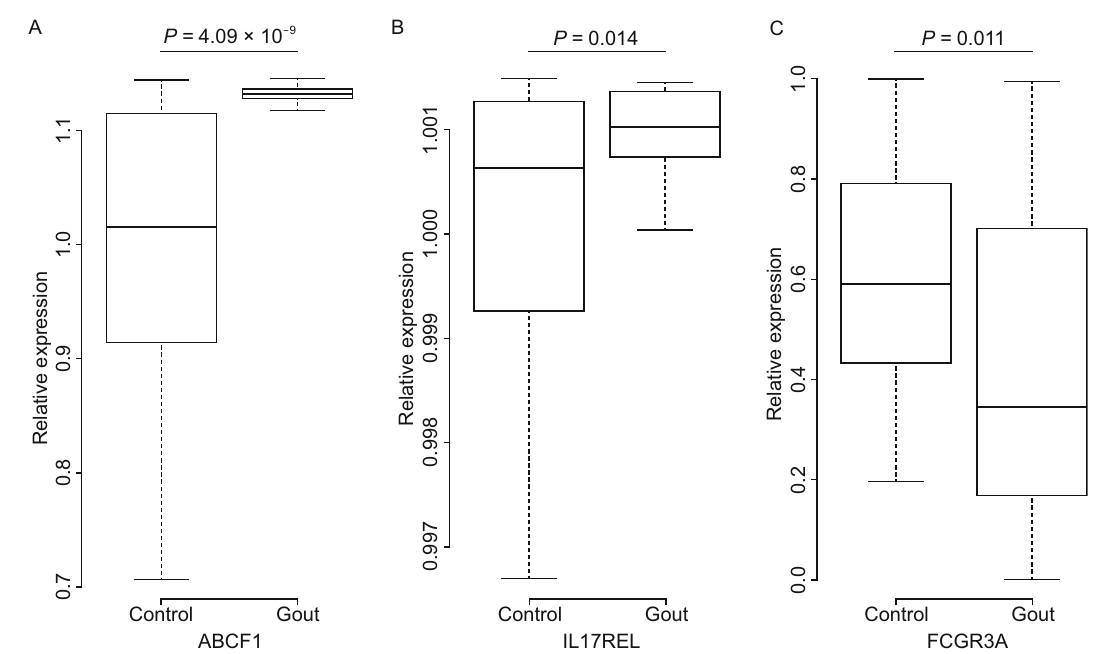
Figure 1. Messenger RNA levels of candidate genes in blood samples from gout patients and healthy individuals . (A) ABCF1 gene; (B) IL17REL gene; (C) FCGR3A gene. SYBR Green-based quantitative polymerase chain reaction (qPCR) was used to test the transcription levels of candidate genes. Data of relative expression were analyzed by Student ’ s t -test. Data are illustrated as boxplots. Upper edge and lower edge of box represents the 75th percentiles and 25th percentiles, respectively. The line inside the boxes represents the median